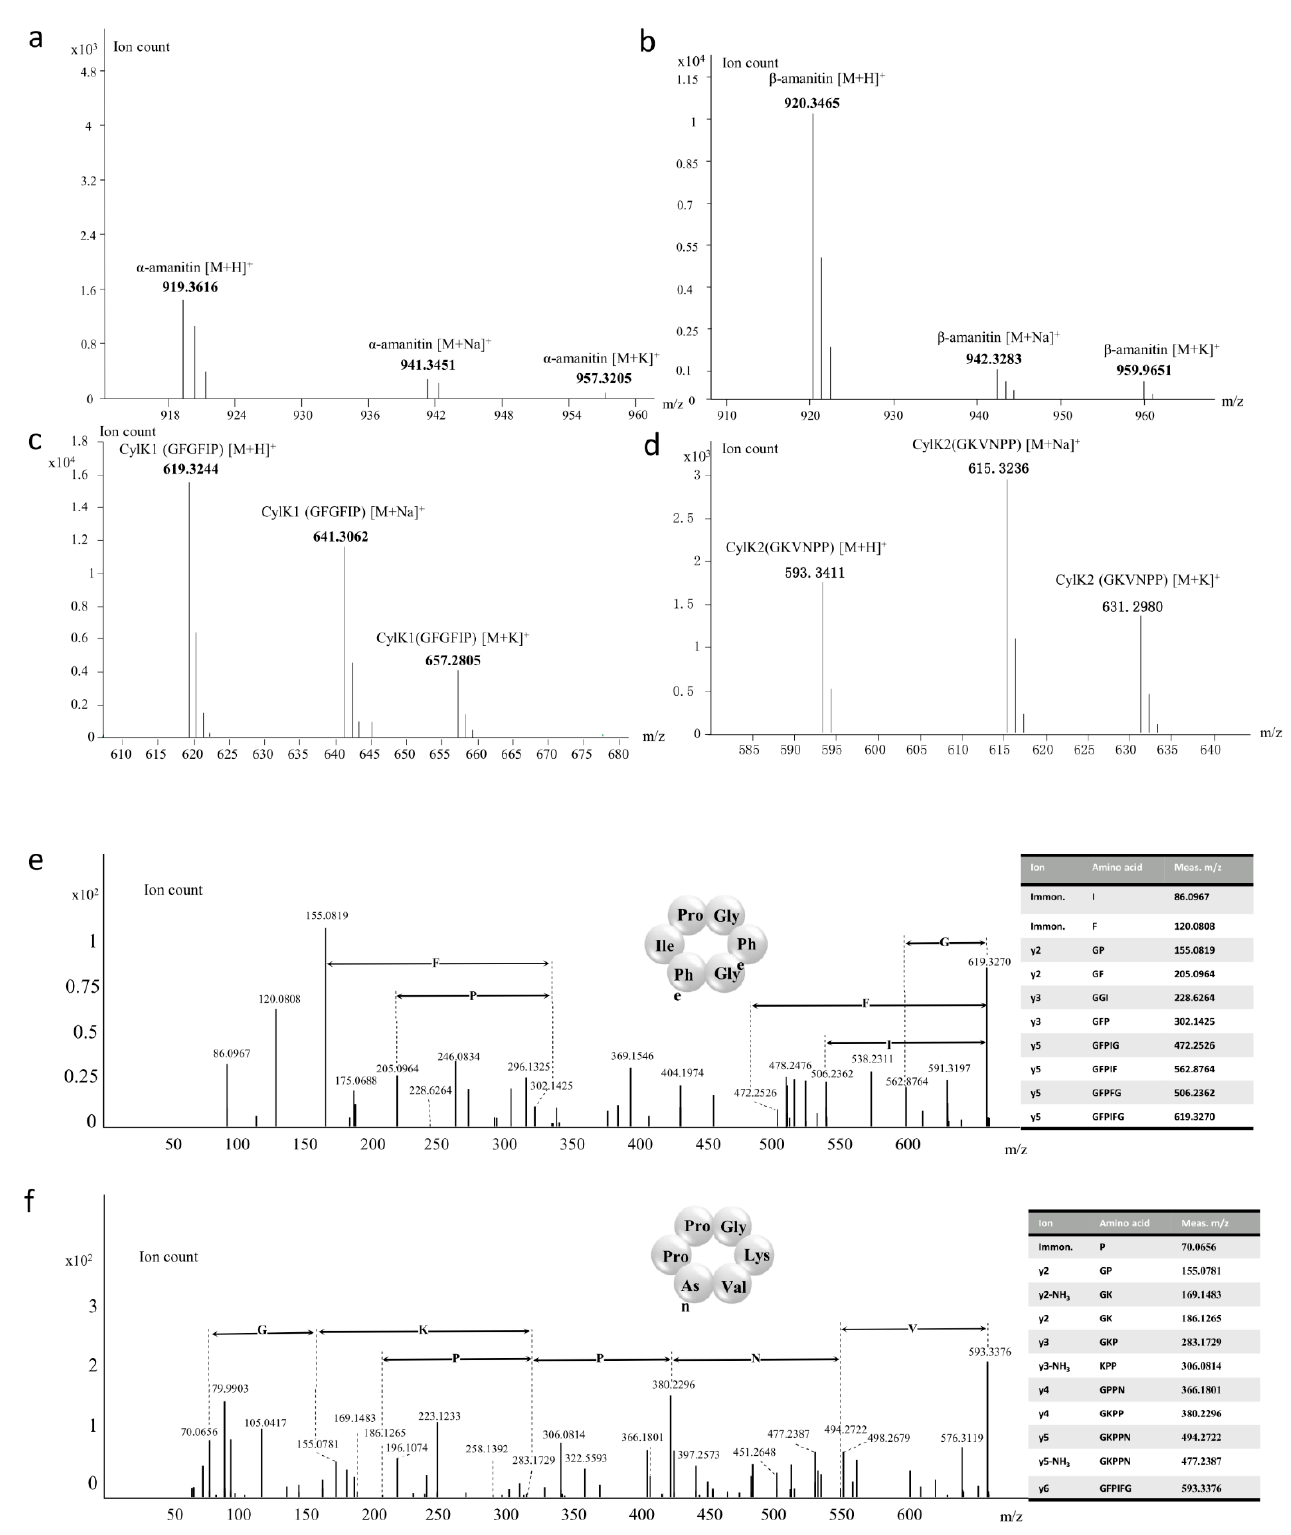
Figure 4. Mass spectrometry spectrograms of known and novel cyclic peptides produced in Amanita molliuscula (( a ): α - amanitin, ( b ): β -amanitin, ( c ): CylK1 (Cyclo(GFGFIP)), ( d ): CylK2 (Cyclo (GKVNPP)). Manual analysis of MS/MS fragmentation of the two novel cyclic peptides, CylK1 ( e ) and CylK2 ( f